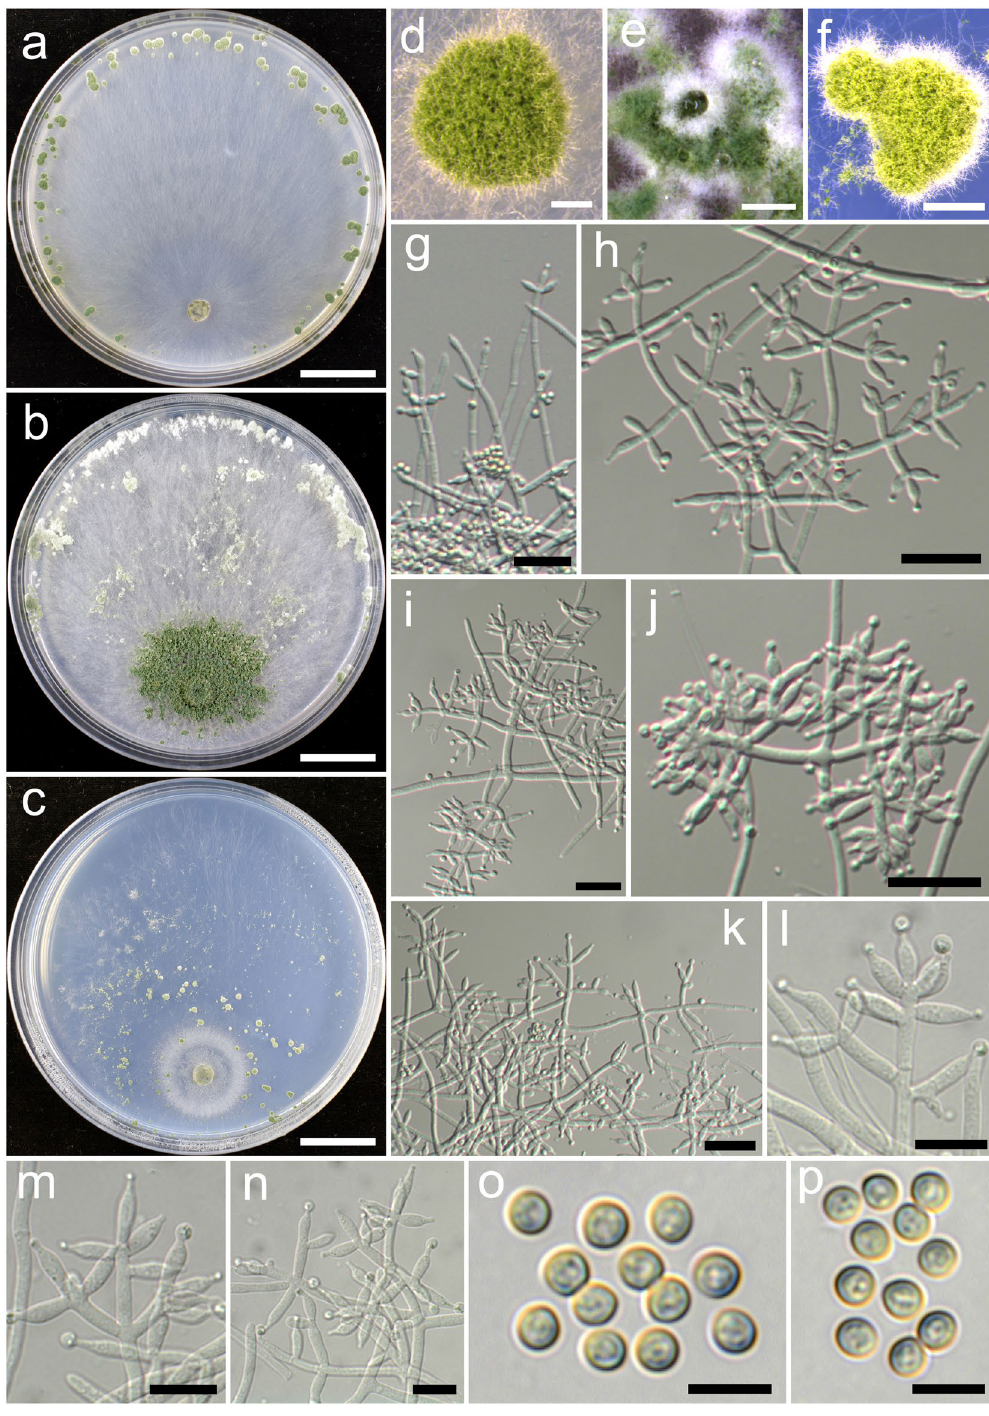
Figure 4. Trichoderma bannaense (HMAS 248840). ( a – c ) Cultures at 25 °C, 10 d (a. on CMD; b. on PDA; c. on SNA); ( d – f ) Conidial pustules (d. CMD, 7 d; e. PDA, 7 d; f. SNA, 7 d); ( g – n ) Conidiophores and phialides (g. SNA, 10 d; h–n. PDA, 3 d); ( o – p ) Conidia (PDA, 3 d). Bars: a–c = 20 mm. d = 250 μ m. e = 400 μ m. f = 800 μ m. g–k = 20 μ m. l–n = 10 μ m. o–p = 5 μ